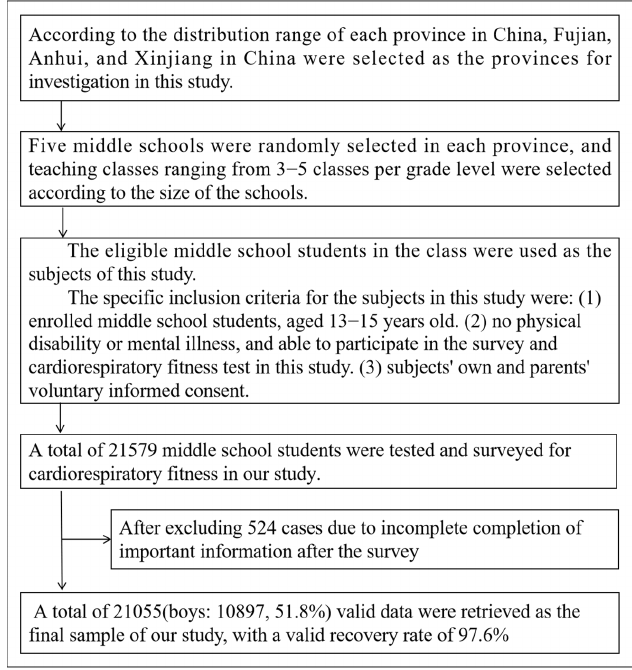
Figure 1. Flow chart of children aged 13–15 in China.